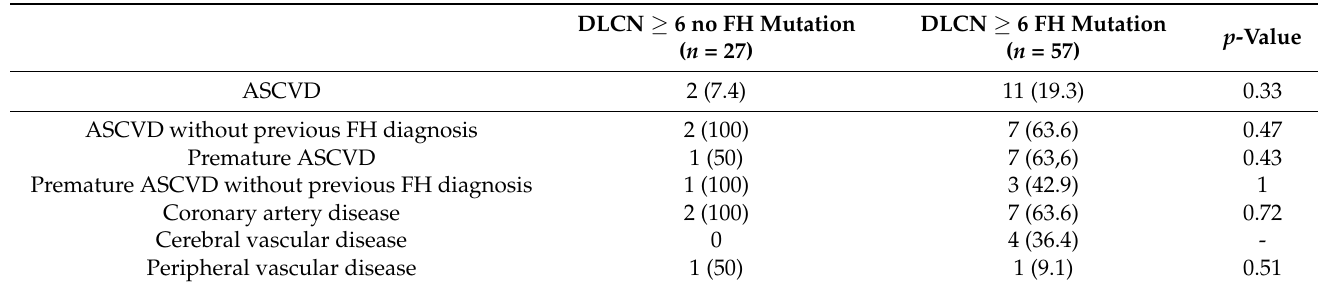
Table 2. Atherosclerotic cardiovascular disease rates in DLCN ≥ 6.